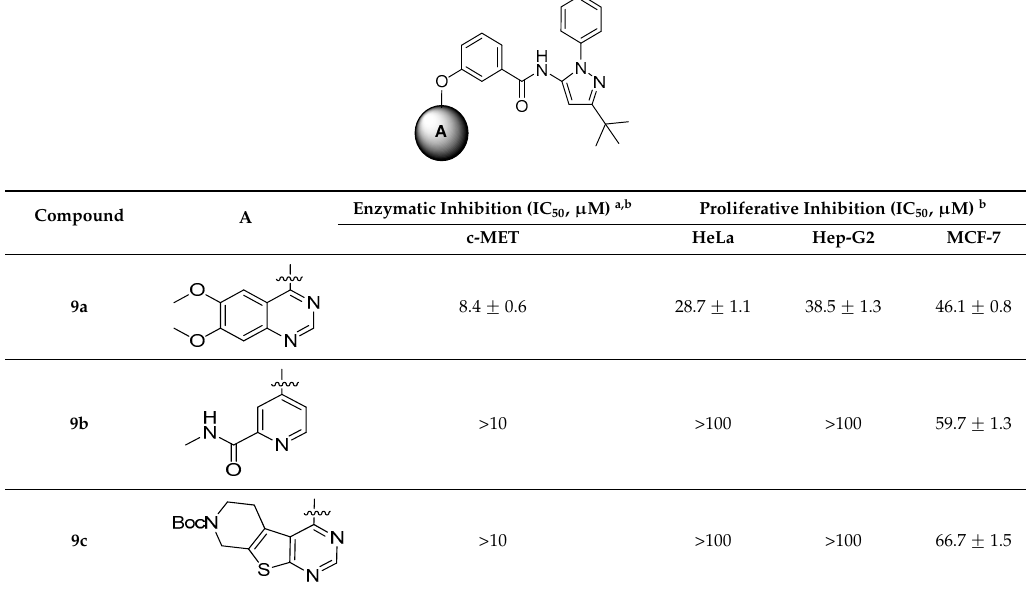
Table 2. Enzymatic and cellular results for compound 11a – c .